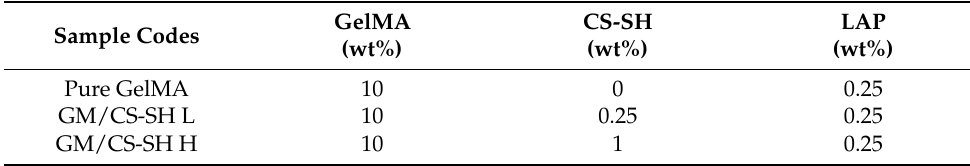
Table 1. Formulations of GM/CS-SH hydrogels